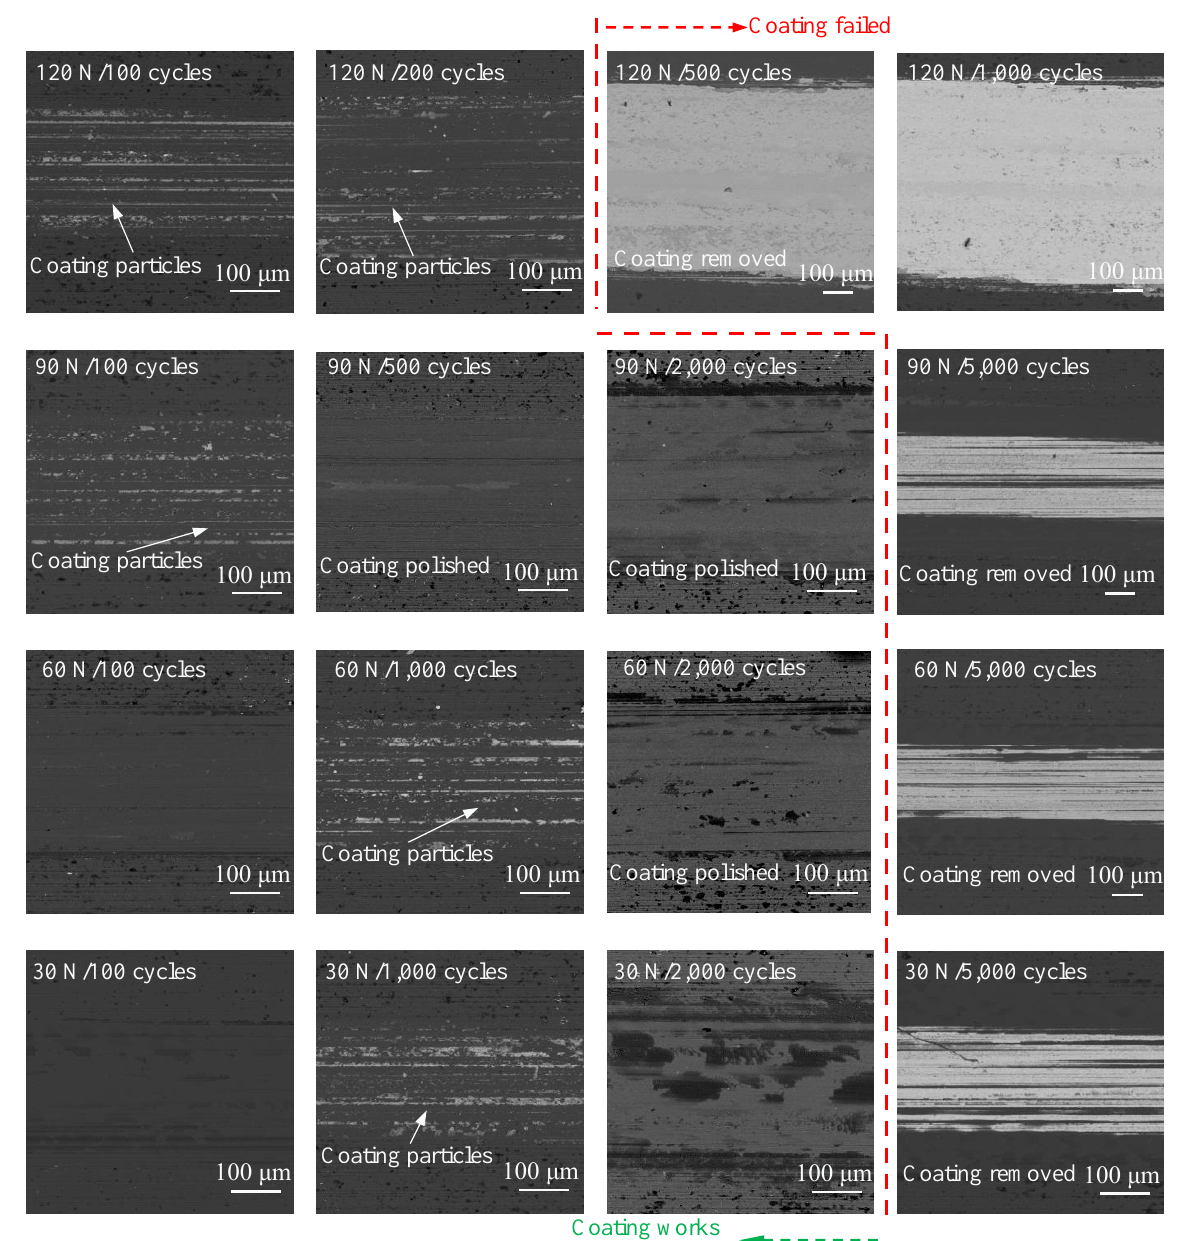
Figure 15. Wear and failure process of AlTiN coating on WC-Co substrate under different normal forces.